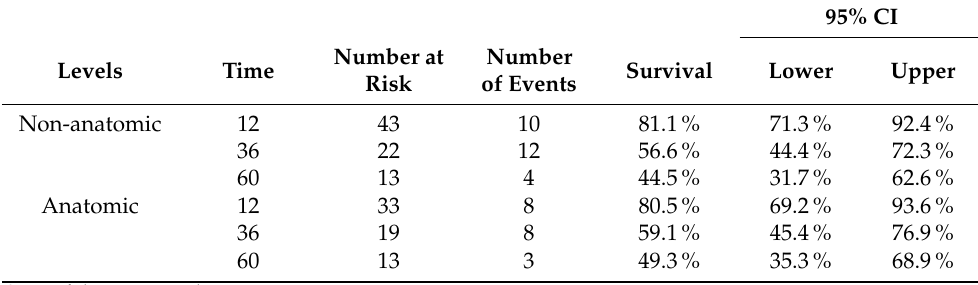
CI, confidence interval.